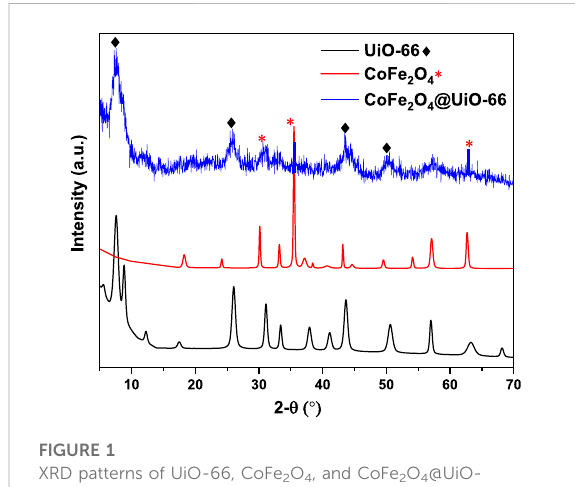
FIGURE 2 FTIR spectra of UiO-66, CoFe 2 O 4 , and CoFe 2 O 4 @UiO- 66